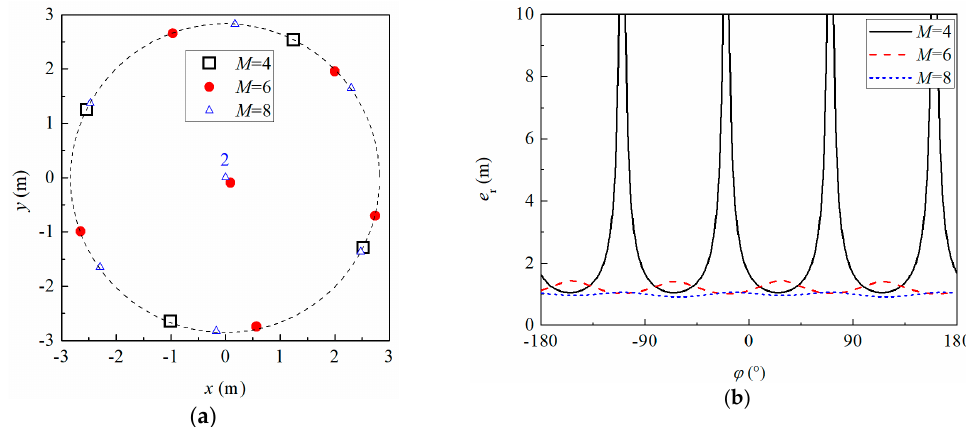
Figure 10. Optimization results of circular constraint area with different numbers of antennas: ( a ) array deployment; ( b ) Cramér-Rao lower bound (CRLB) curve.